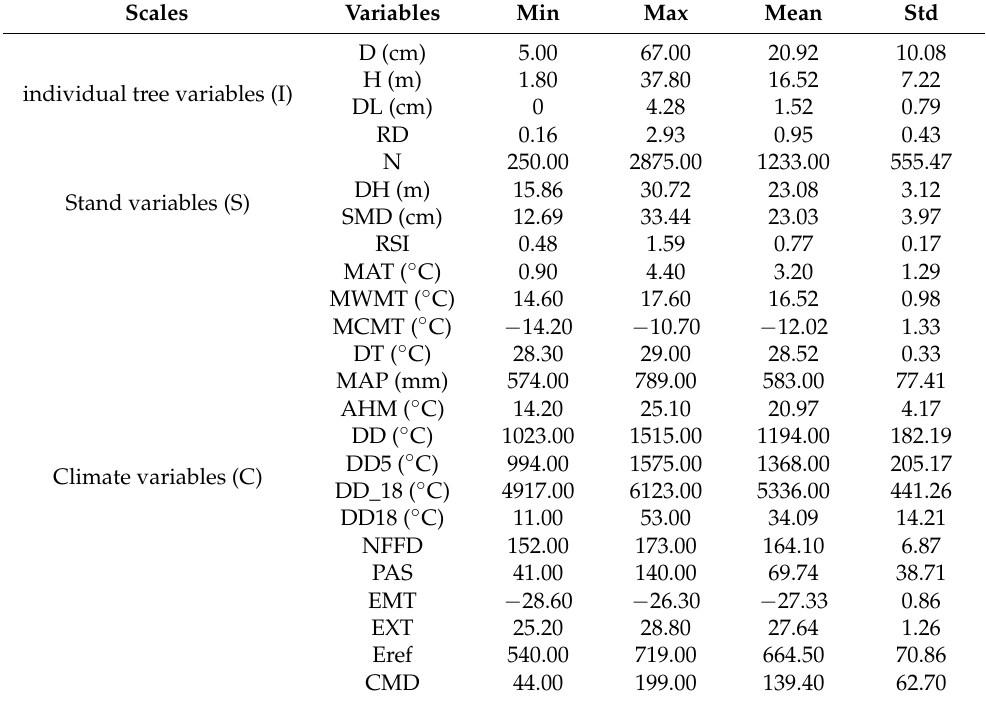
Table 2. Summary statistics of the variables at three levels. D: Diameter at breast height, H: Individual tree height, DL: Sum of squares of tree diameters greater than the estimated diameter, RD: Ratio of subject tree diameter to average square diameter of stand, N: Stand density, DH: Stand dominant height, SMD: Stand mean quadratic diameter, RSI: Relative spacing index, and the meanings of climate variables are shown in Table